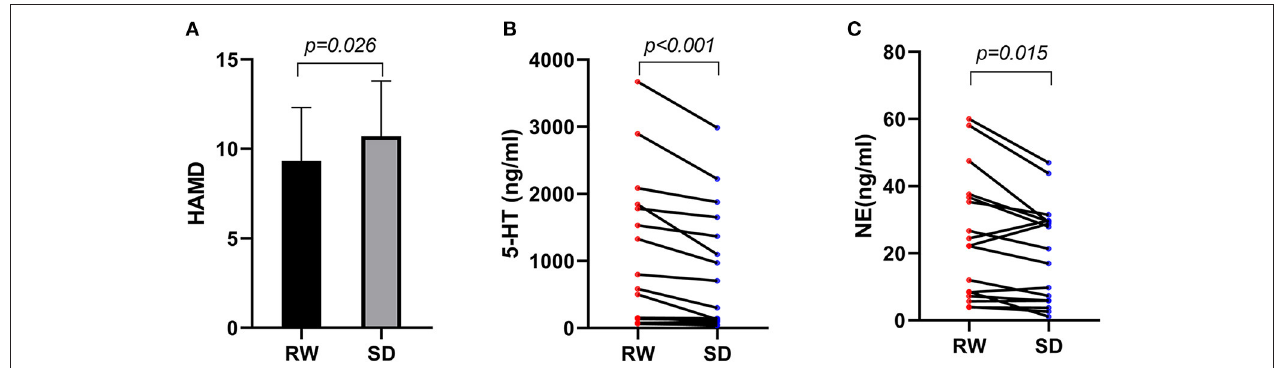
FIGURE 1 | (A) HAMD scores within subjects at RW and after SD, n = 21. (B) 5-HT serum concentration of participants at RW and after SD, n = 17. (C) NE serum concentration of participants at RW and after SD, n = 17. HAMD, Hamilton Depression Rating Scale; RW, rested wakefulness; SD, sleep deprivation; 5-HT, serotonin; NE,